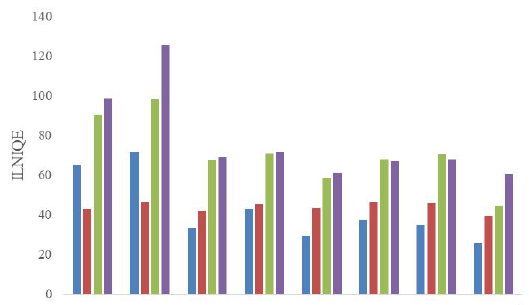
Figure 6. ILNIQE of different methods in Fig.4